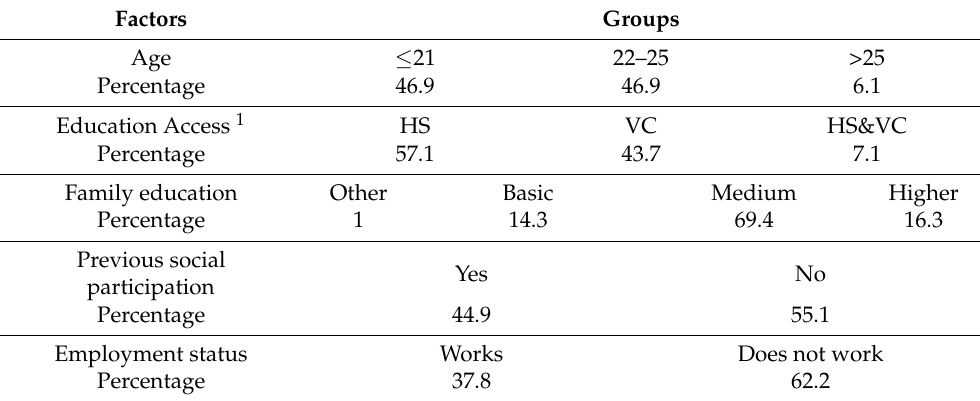
Table 1. Factors examined, groups and percentages within the sample.